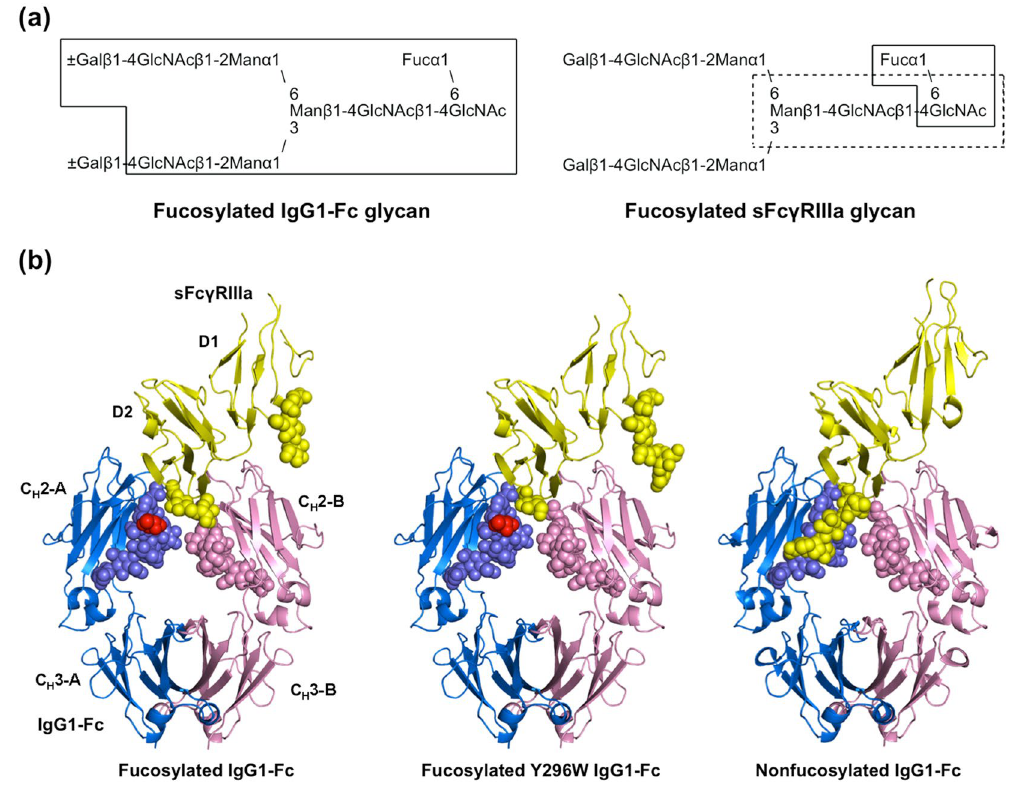
Figure 1. Crystal structures of IgG1-Fc/sFc γ RIIIa complexes. ( a ) Schematic representation of N -glycans expressed on fucosylated wild-type IgG-Fc (left) and sFc γ RIIIa (right) used for crystallization, showing the nomenclature of oligosaccharide residues and branches. Sugar residues that gave interpretable electron densities are surrounded by solid polygons in Fc-Asn-297 N -glycans and sFc γ RIIIa-Asn-162 N -glycans, whereas those in the sFc γ RIIIa-Asn-45 N -glycan are indicated by a dashed box. ( b ) Crystal structures of Fc fragments in complex with the bis- N -glycosylated soluble form of sFc γ RIIIa: left, fucosylated wild-type IgG1-Fc; center, fucosylated Y296W IgG1-Fc; right, nonfucosylated wild-type IgG1-Fc (PDB code: 3AY4). Chain A of Fc fragment, chain B of Fc fragment, and sFc γ RIIIa are colored by marine, pink, and yellow, respectively. Fucose residues are colored in red. Carbohydrate residues are represented as